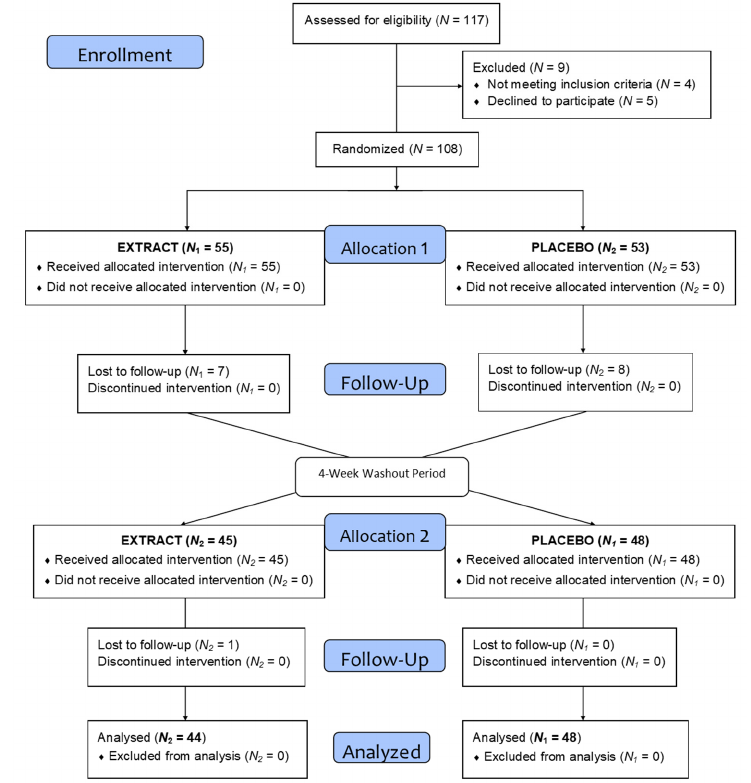
Figure 2. Flow diagram. Table 2. Demographic data.